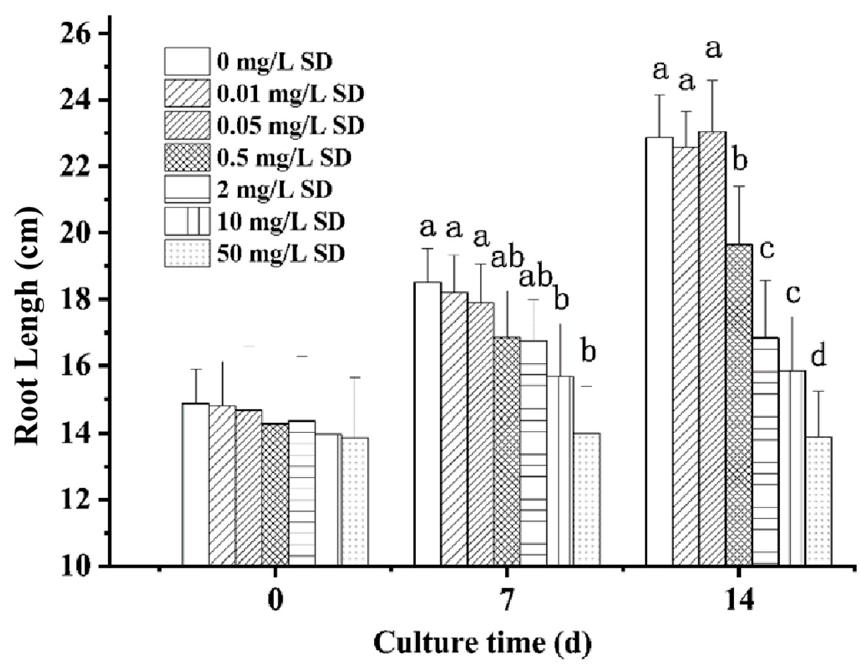
Figure 2. Effect of SD concentration on the root length of lettuce. Error bars represent the standard deviations of the means ( n = 15), and a–d on top of the error bars represent significant differences ( p < 0.05) among different initial concentrations of treatments.